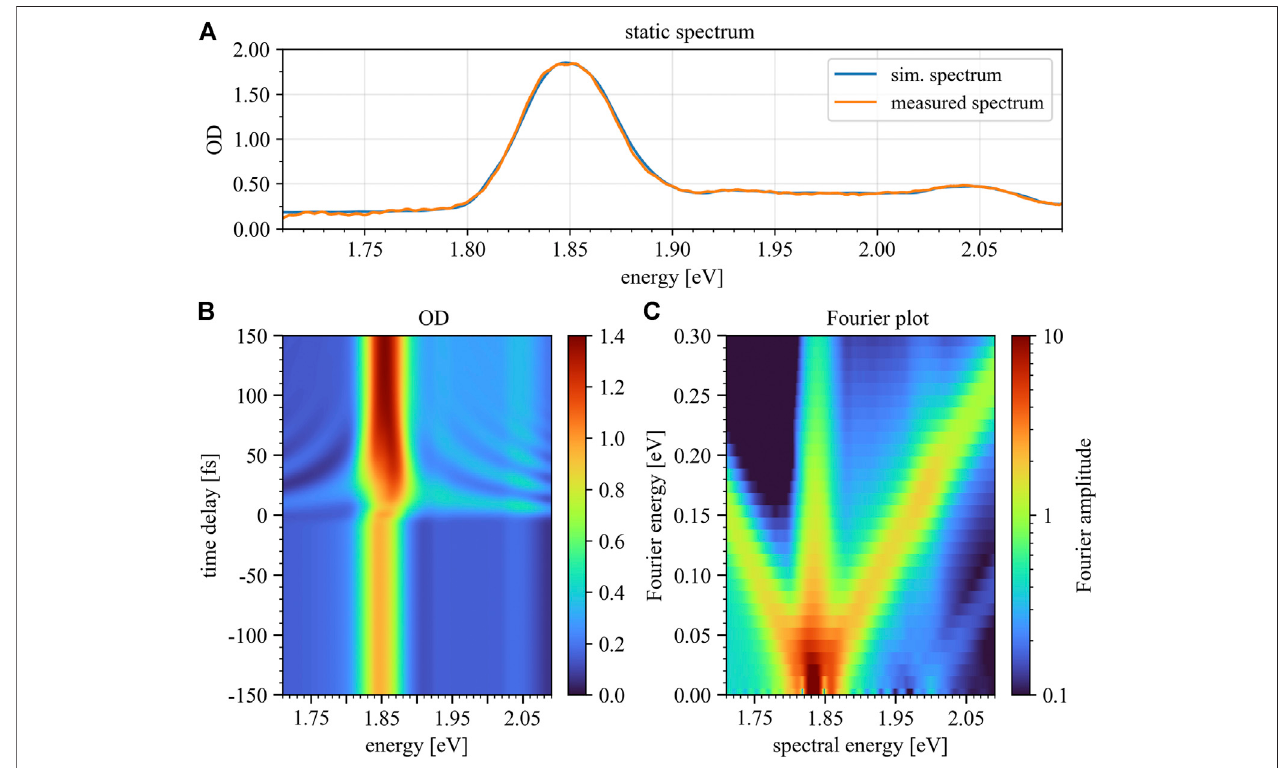
FIGURE 7 | Simulated static absorption spectrum (A) , time-delay trace (B) and Fourier plot (C) for positive time delays only. Panel 7B depicts the modeled optical density over atime-delay range of300 fs,wherethecolorbar marksthemagnitude ofOD. TheFourier plot(Panel7C)revealsdiagonals withslope ± 1inasimilar fashion as seen in the experimental data. Negative time delays refer to control-pulse fi rst, positive to excitation-pulse fi rst.